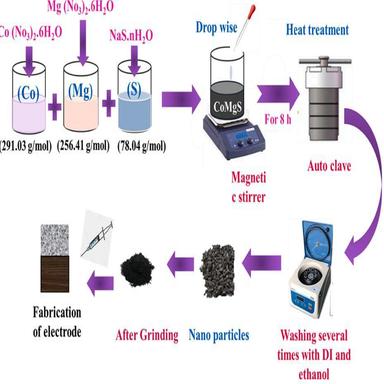
An illustration of a hydrothermal synthesis process for the synthesis of CoMgS and electrode deposition.